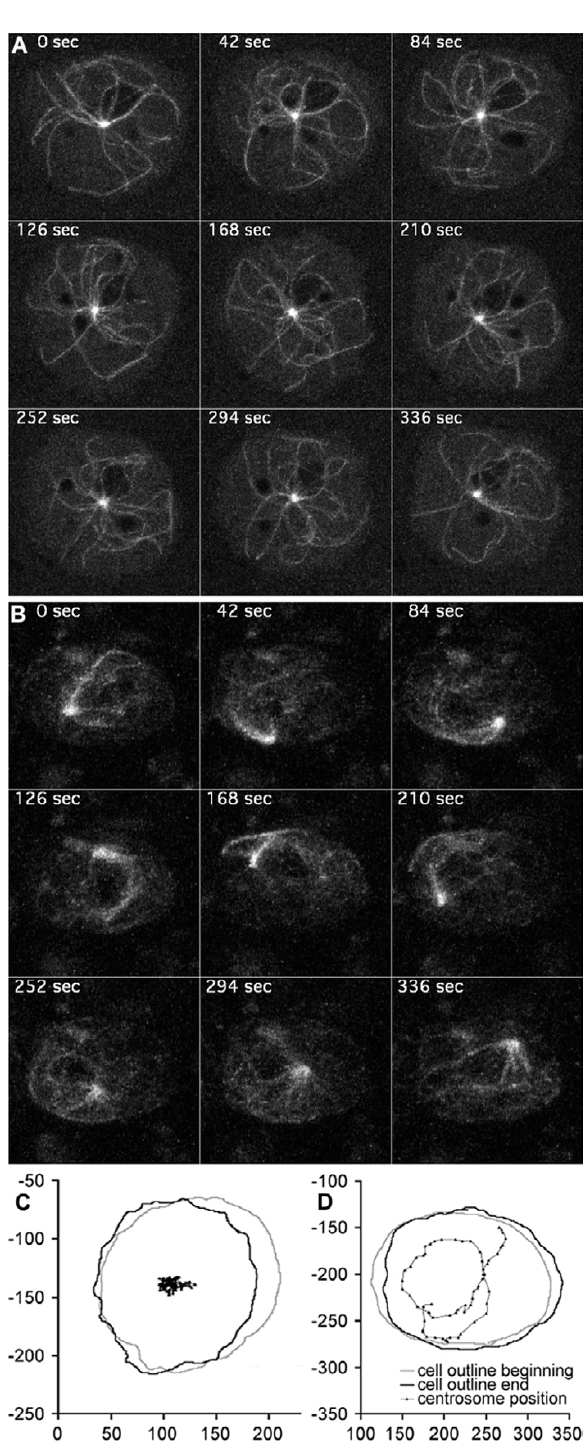
Figure 2 Microtubule and centrosome dynamics upon overexpression of DdCP224- ∆ C. GFP- α -tubulin control cells (A, see additional data file movie1.mov) and GFP- α -tubulin cells overexpressing DdCP224- ∆ C (B, see additional data file movie2.mov) were analyzed by confocal 4D-microscopy as described [5]. Each image represents a brightest point z-projection of 5 confocal slices with a distance of 1 µ m each. The time is indicated in seconds. The movements of the centrosome shown in (C) for con- trol cells and in (D) for DdCP224- ∆ C/GFP- α -tubulin cells were calculated from 60 single images each using